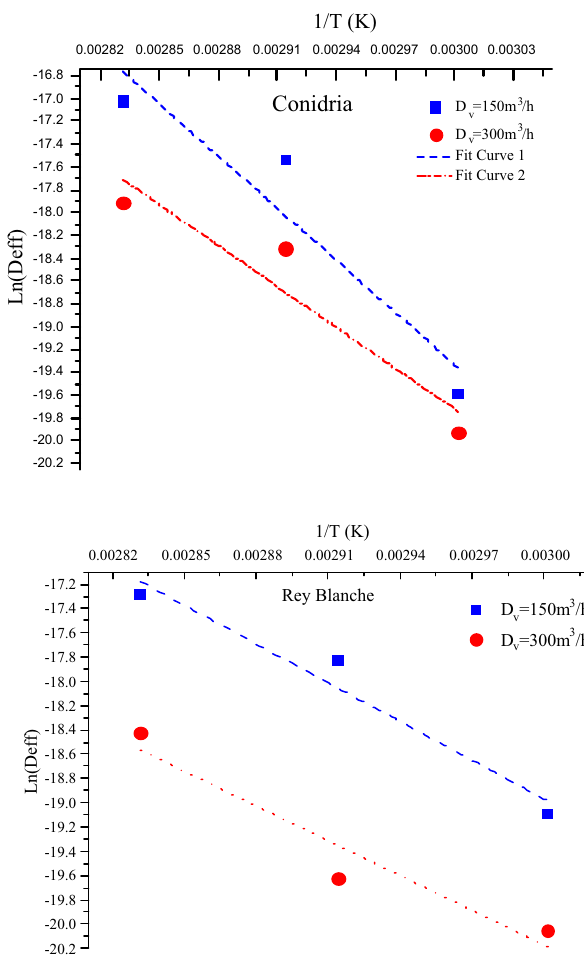
Figure 9. Ln(Deff) versus 1/T for both fig varieties at different air flows drying.